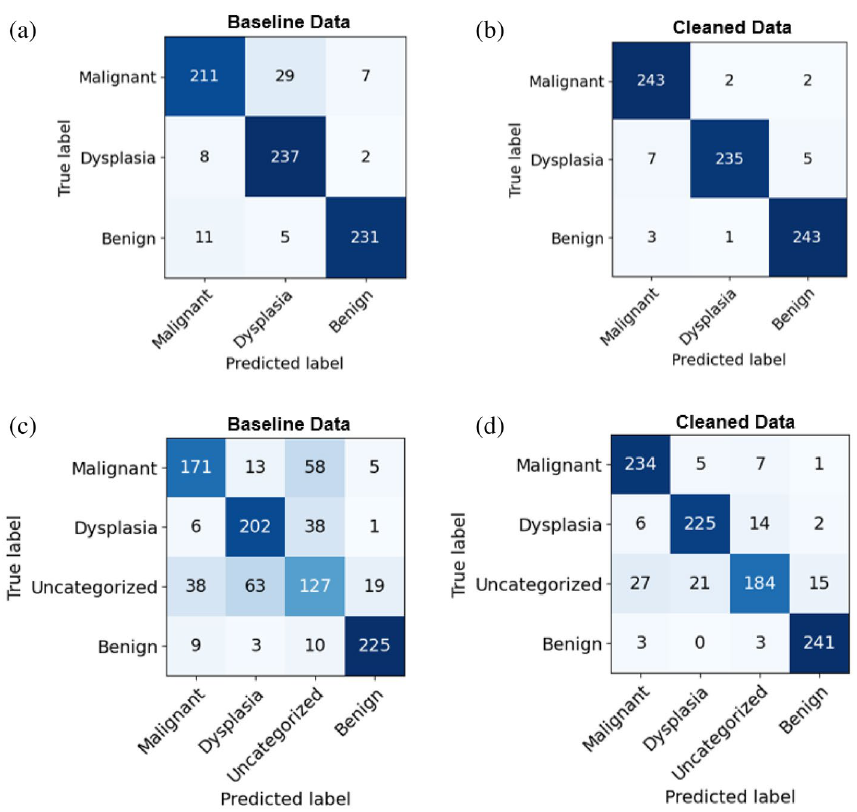
Figure 7. Confusion matrix for ternary classes in the first row ( a,b ) and quaternary classes in the second row ( c,d